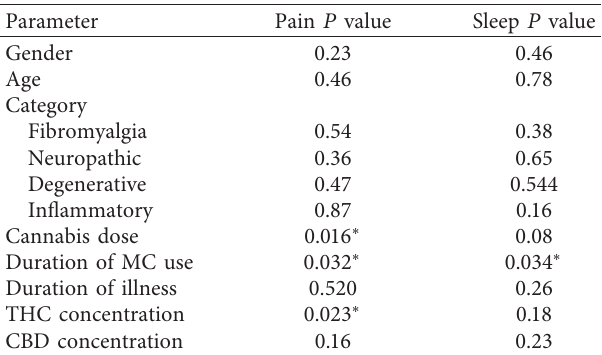
Table 4: Multilinear regression analysis correlating pain and sleep response (separately) with different independent